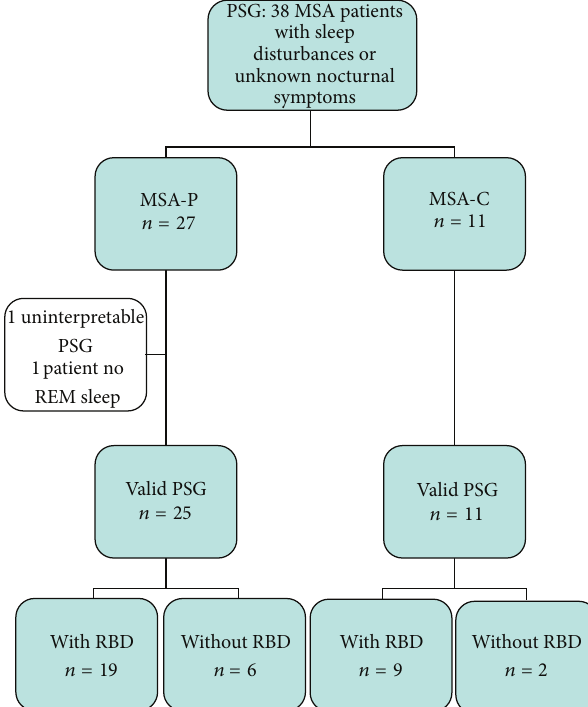
Figure1:StudytreeoftheMSApatients.RBD=REMsleepbehavior disorder, PSG =